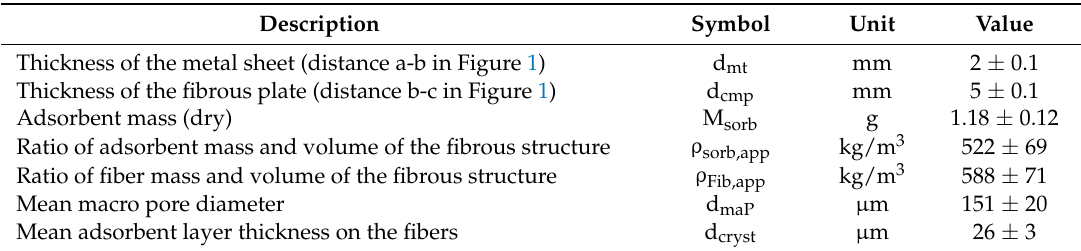
Table 1. Data of the fibrous structure directly crystallized with SAPO-34 (2_Fib).